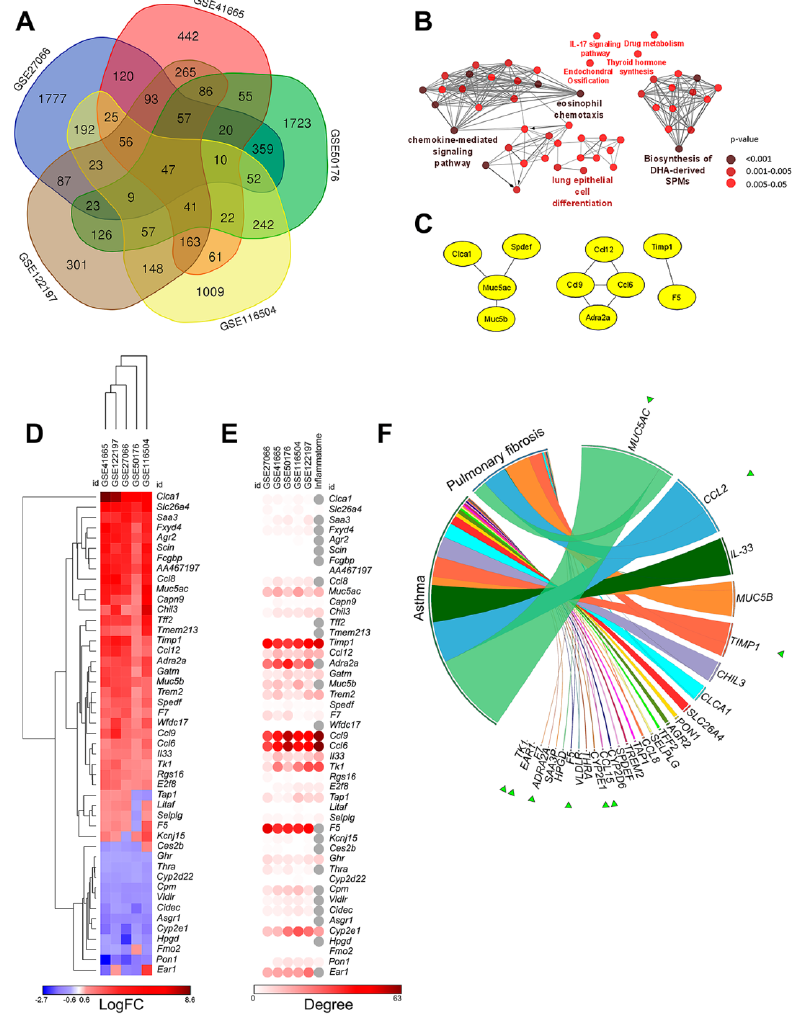
Figure 2. Key genes involved in the development of ovalbumin (OVA)-induced asthma identi- fied by bioinformatics analysis. ( A ) Venn diagram of overlap between differentially expressed genes (DEGs) identified by re-analysis of GSE41665, GSE116504, GSE122197, and GSE27066 datasets of OVA-induced asthma and GSE50176 dataset of nanotube-induced allergic lung inflammation. ( B ) Functional analysis of overlapped DEGs identified in different GSEs. Enrichment for Gene On- tology (biological processes), KEGG, REACTOME, and WikiPathways terms were performed using ClueGo plugin in Cytoscape. The labels of the most significant terms are shown. Color of nodes represents the term enrichment significance. Only pathways with p < 0.05 after Bonferroni step-down correction for multiple testing were included in the networks. ( C ) Protein–protein interaction (PPI) network reconstructed for the 47 common DEGs between all asthma-related datasets using STRING database (confidence score ≥ 0.7, maximal number of interactors = 0) in Cytoscape. ( D ) Heat map demonstrating expression levels of DEGs in different GSEs. Heat map construction and hierarchical clustering (Euclidian distances) were performed using Morpheus [38]. LogFC = Log 2 (fold change). ( E ) Heat map demonstrating interconnection of DEGs in PPI reconstructed for each asthma-related dataset using STRING database (confidence score ≥ 0.7, maximal number of interactors = 0) in Cytoscape. Degree—number of interactions between DEGs and its partners. ( F ) Co-occurrence of identified DEGs with relevant keywords in scientific literature deposited in the MEDLINE database. Analysis was performed using GenClip3 web service. Data were visualized via Circos. Green triangles indicate key genes included in the top-10 interconnected